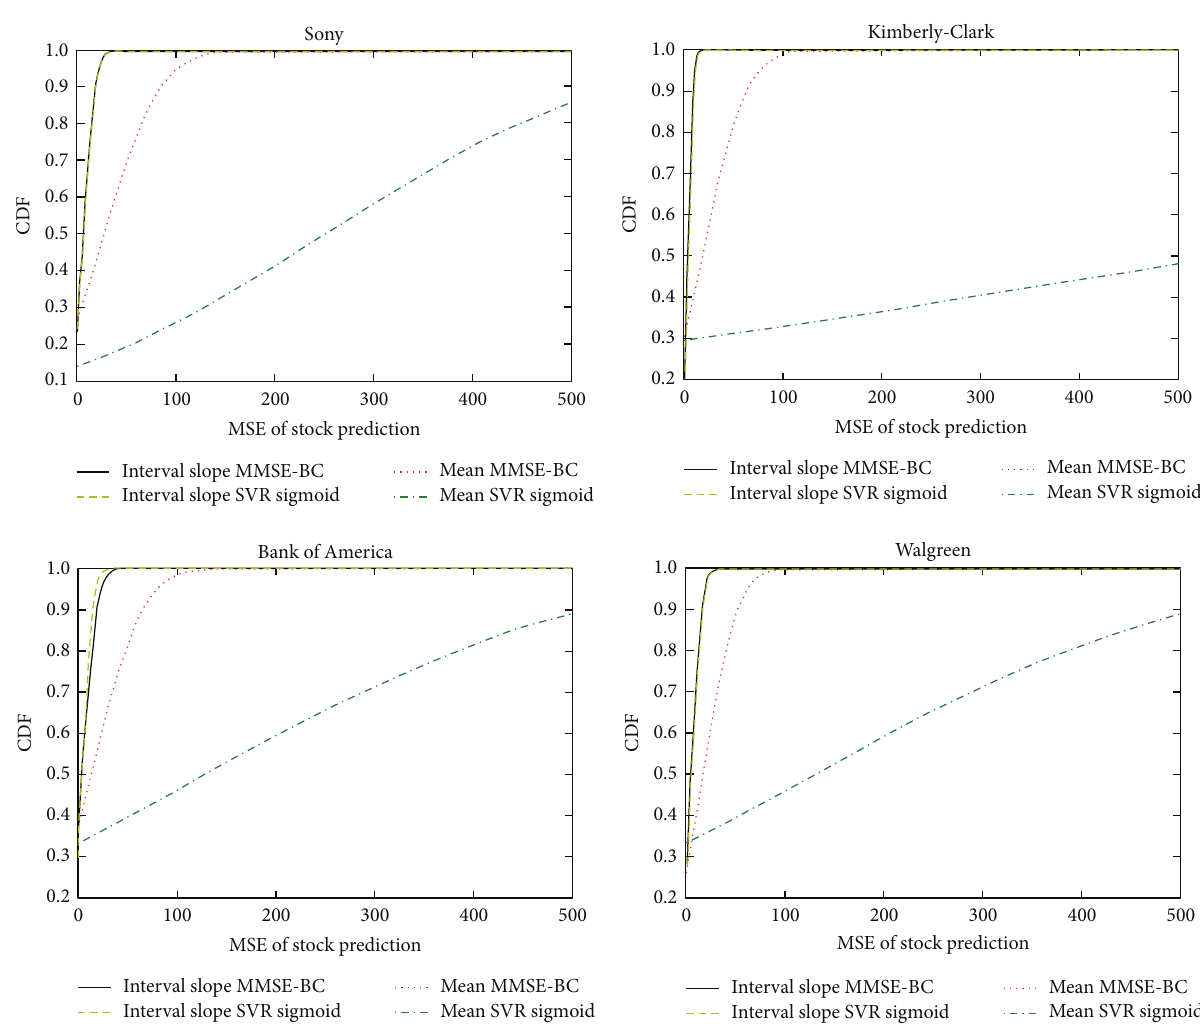
Figure 5: CDF of MSE for prediction of trends in stock